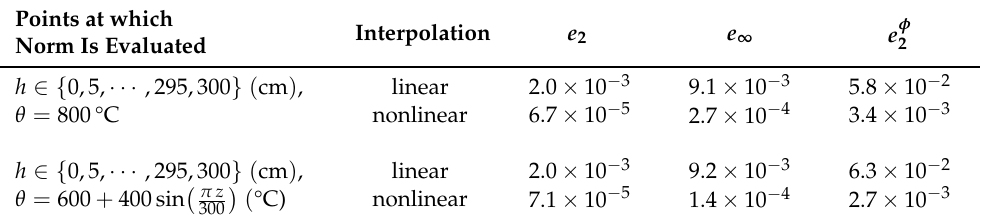
Table 3. Error in k eff and scalar flux predicted by reduced-order model (GPOD) for un- ROM seen parameters as stated. Values for both linear and nonlinear interpolation are given (see Equations (28) and